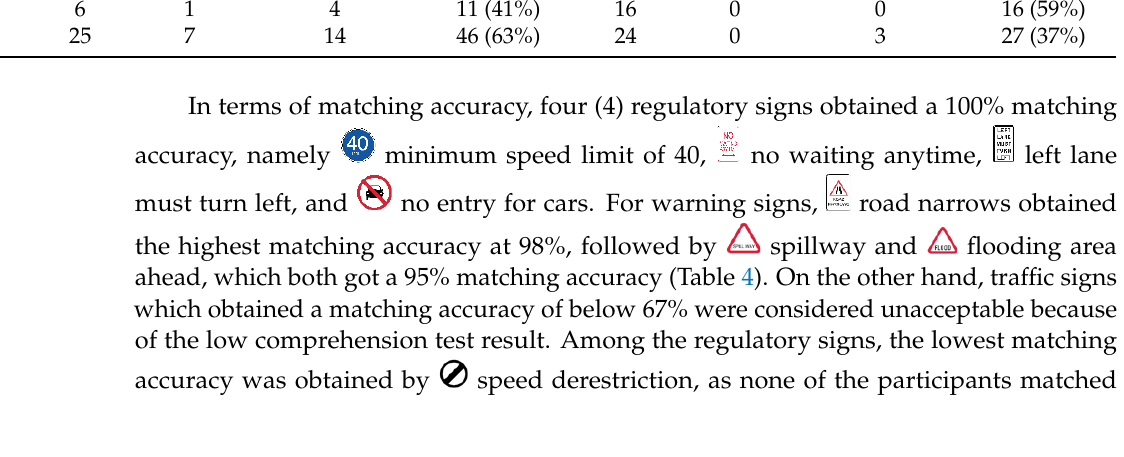
Table 3. The evaluation result of the traffic signs based on the 67% passing rate set by 1SO 3864- 1:2011.